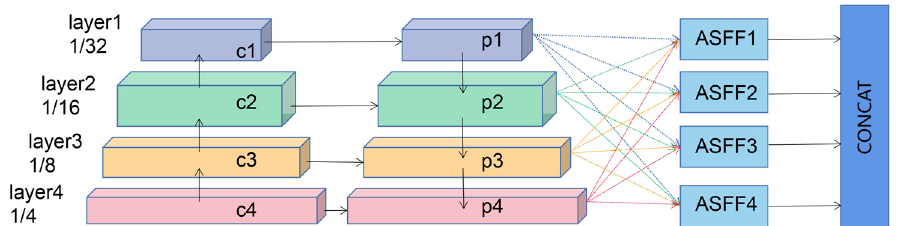
Figure 4. Adaptive multi-layer feature fusion module